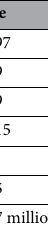
Table 2. Parameters from the assembly of transcriptome reads from sacha inchi